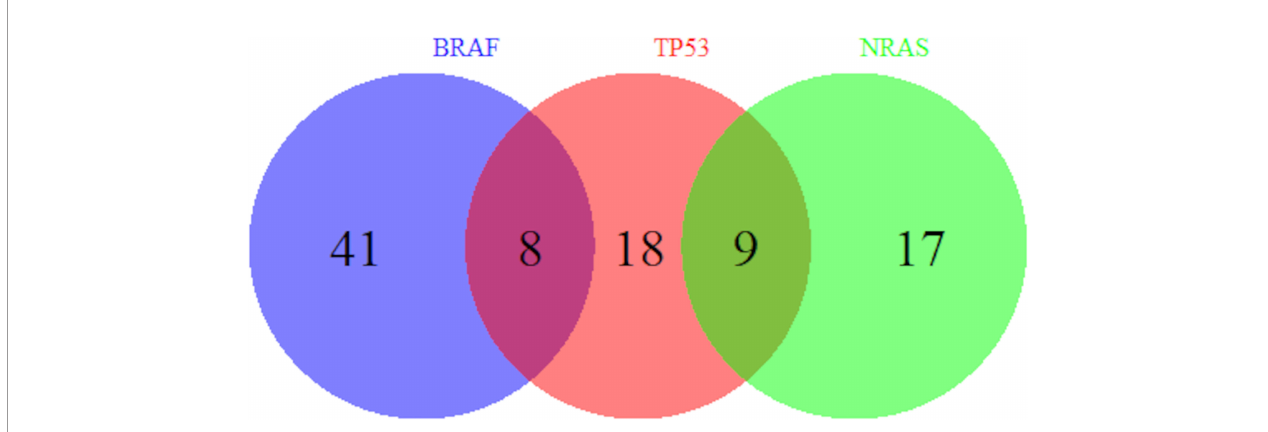
FIGURE 1 | Overlap of BRAF , TP53 , and NRAS Mutations. Number of Veterans with melanoma harboring BRAF , TP53 , and NRAS mutations out of our cohort of 135 Veterans are shown. A subset of melanomas has both BRAF and TP53 mutations and another subset has both NRAS and TP53 mutations. However, BRAF and NRAS mutations are mutually exclusive.